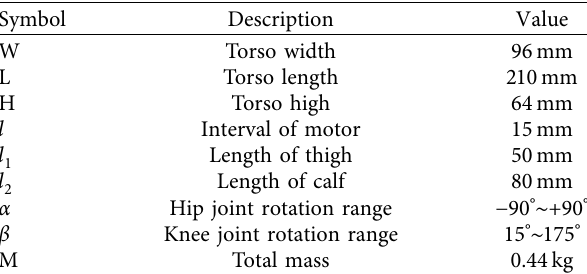
Figure 5: Side view of the quadruped robot. Table 1: The structural design